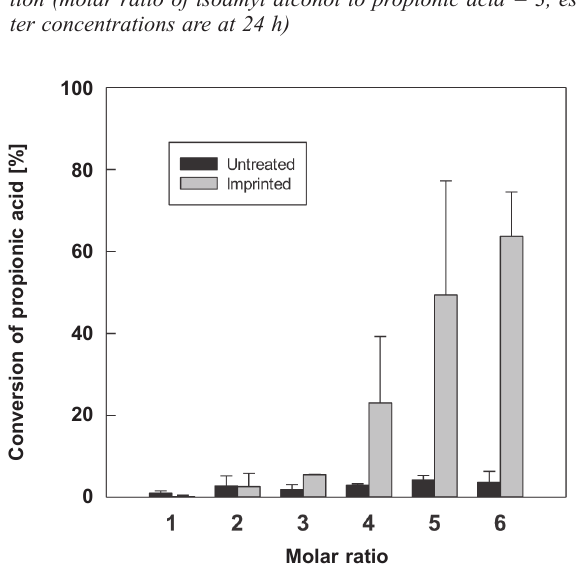
Fig. 3 – Effect of molar ratio to conversion of propionic acid to isoamyl propionate with untreated and imprinted